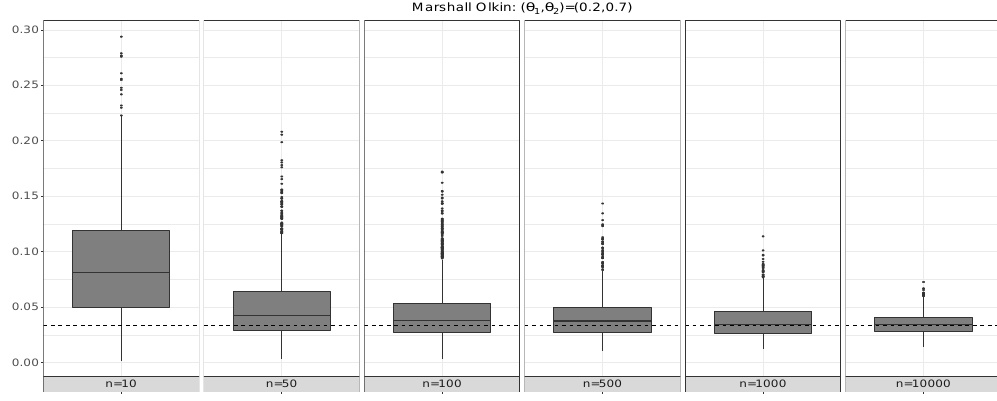
( Y | X ) at levels α = 0.05 and γ = 0.05 α , γ , M 0.2,0.7